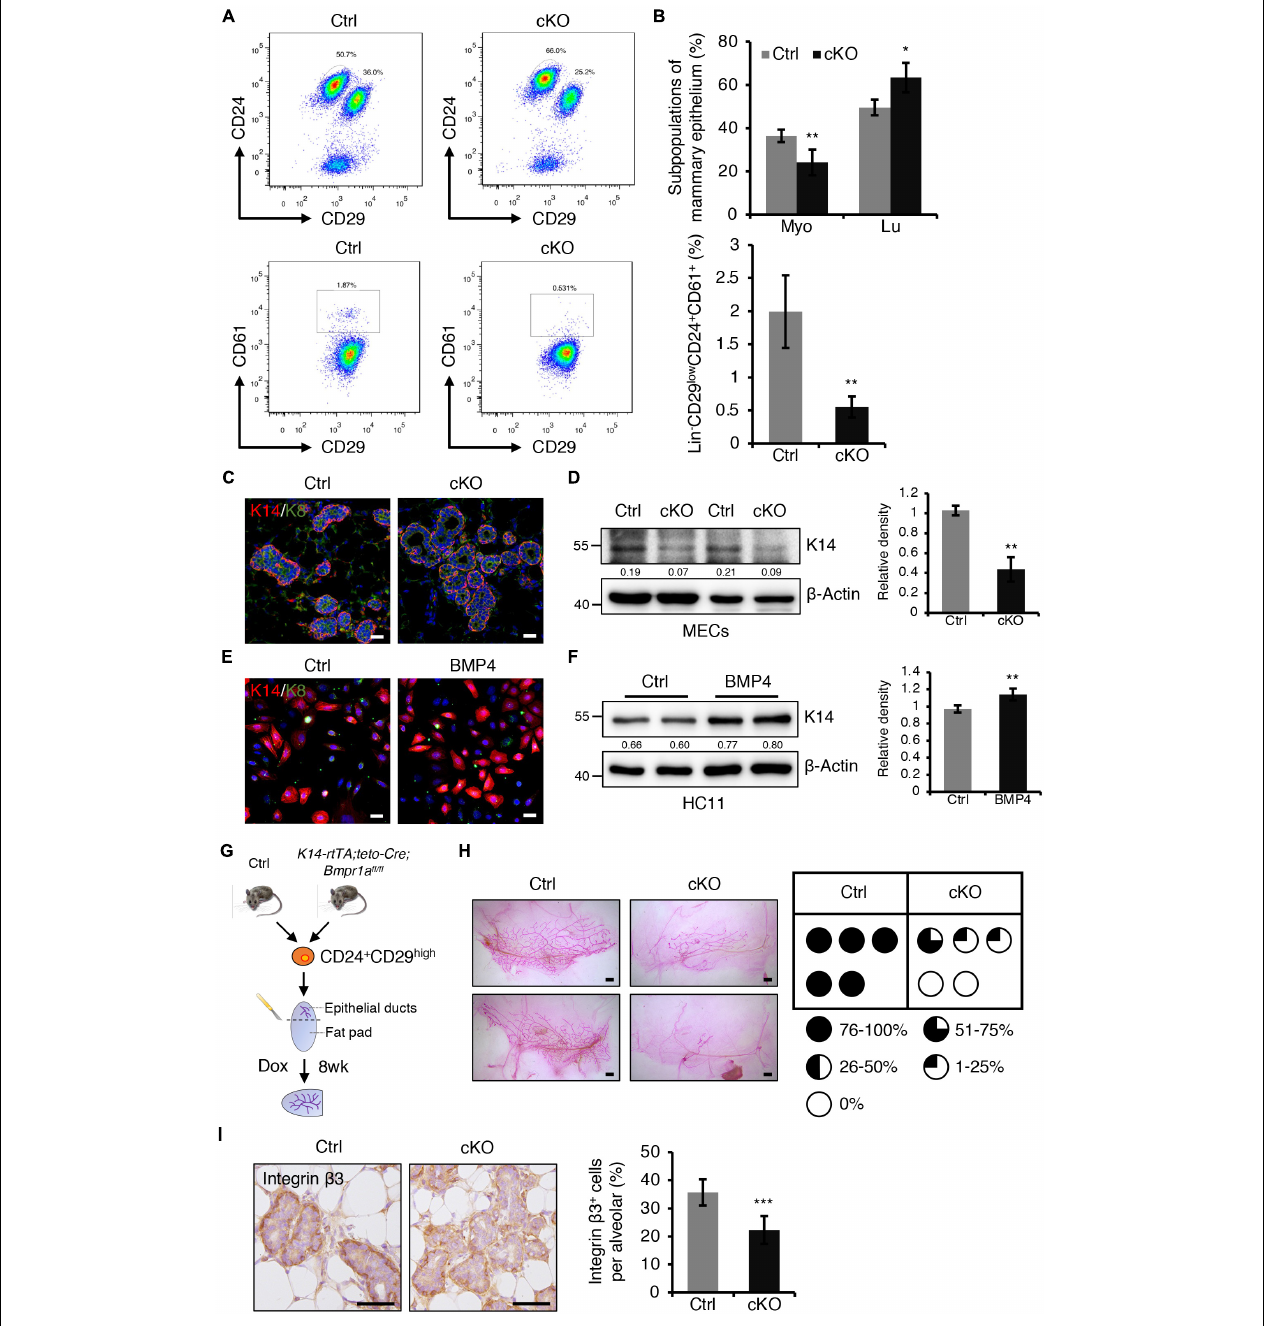
(B) Quantification of Lin - CD24 + CD29 high (Myo), Lin - CD24 + CD29 low (Lu) and Lin - CD24 + CD29 low CD61 + cell populations in control and cKO mice at pregnancy day 14.5. n = 4 biological replicates. (C) Immunofluorescence staining for K14 (red) and K8 (green) in control and cKO mammary glands at pregnancy day 14.5. n = 3 mice per group. Scale bar, 25 µ m. (D) Western blotting for K14 in control and cKO mammary glands at pregnancy day 14.5. β -Actin was used as a loading